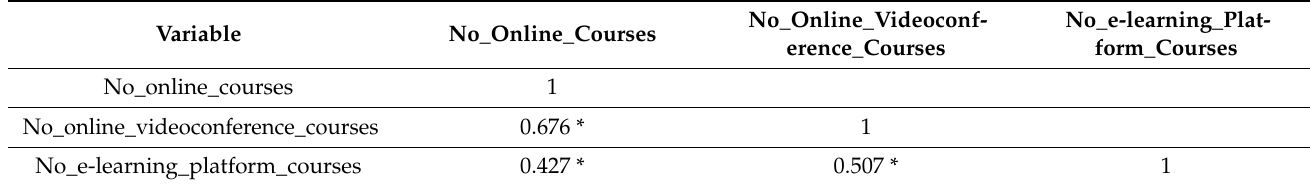
Table 23. Correlations matrix of major variables related to the online level.